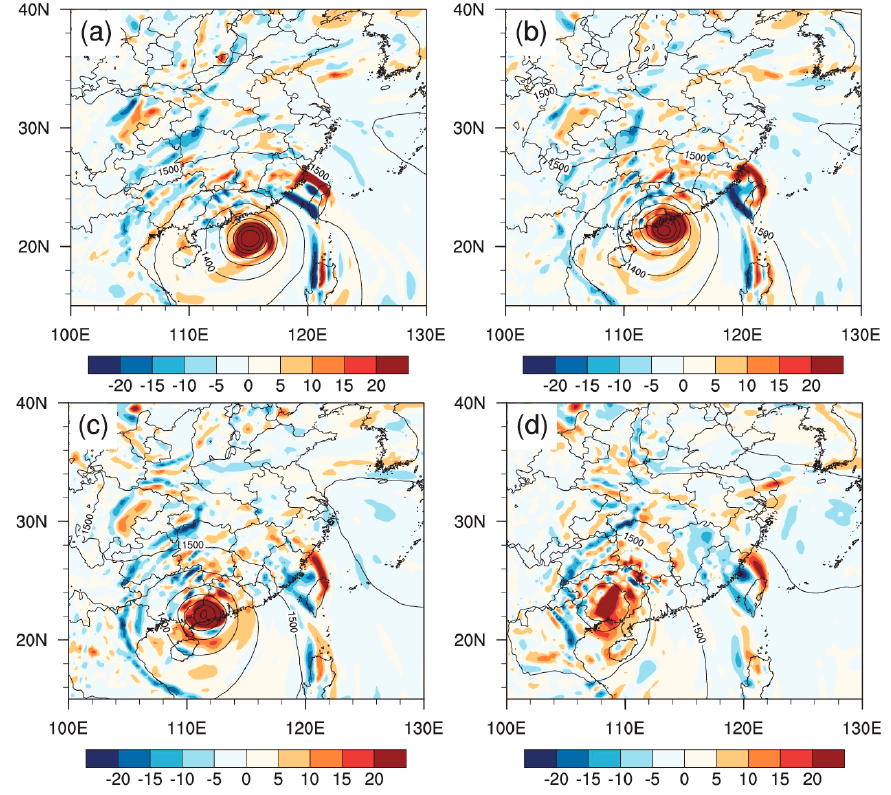
Figure 8. Relative vorticity (10 − 5 s − 1 ) at 850 hPa at ( a ) 0000 UTC 16 September, ( b ) 0600 UTC 16 September, ( c ) 1200 UTC 16 September, and ( d ) 0000 UTC 17 September 2018.